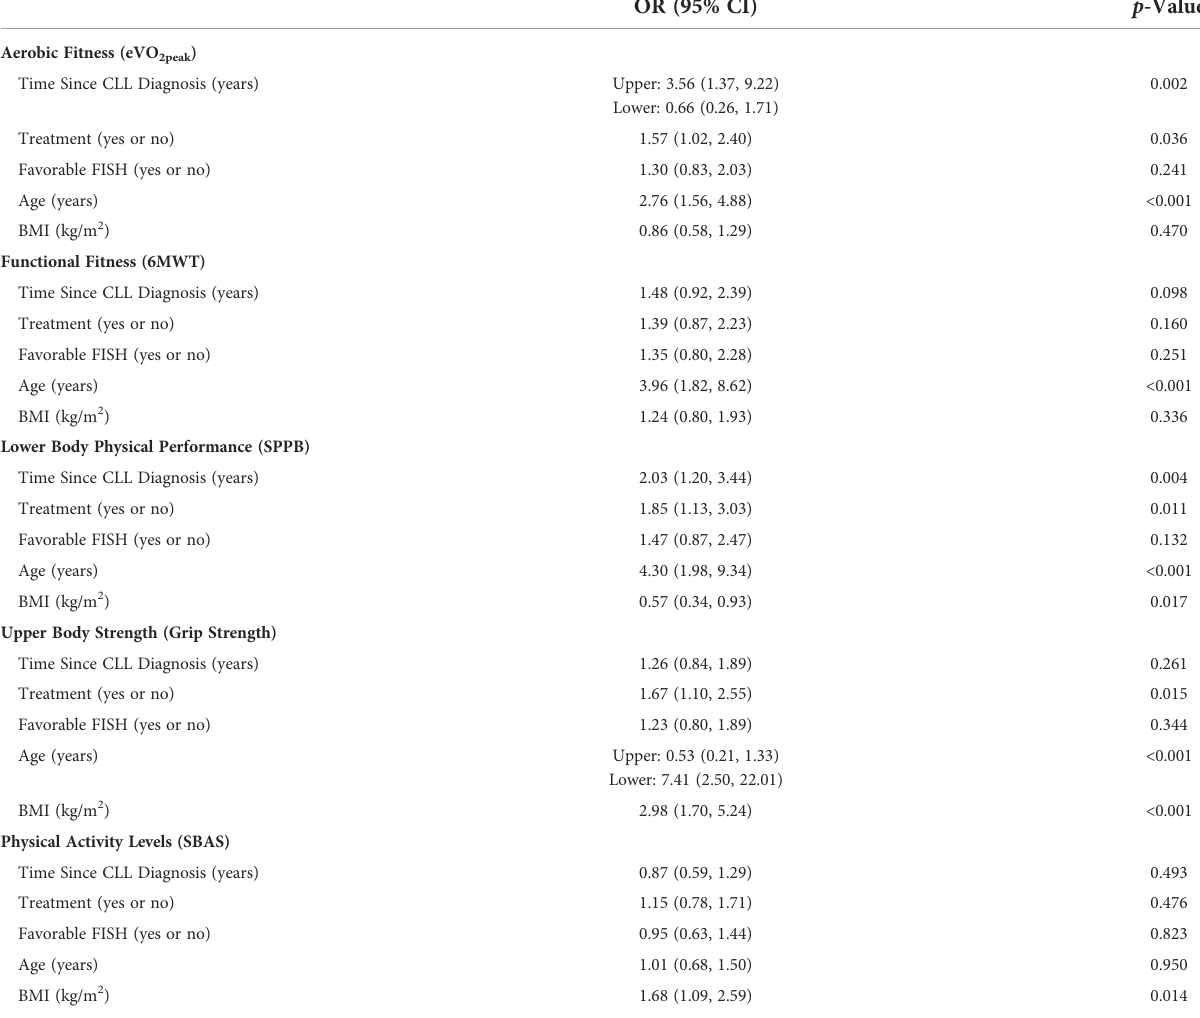
TABLE 3 Univariable associations between clinical factors and the odds of having dysfunctional physical characteristics *